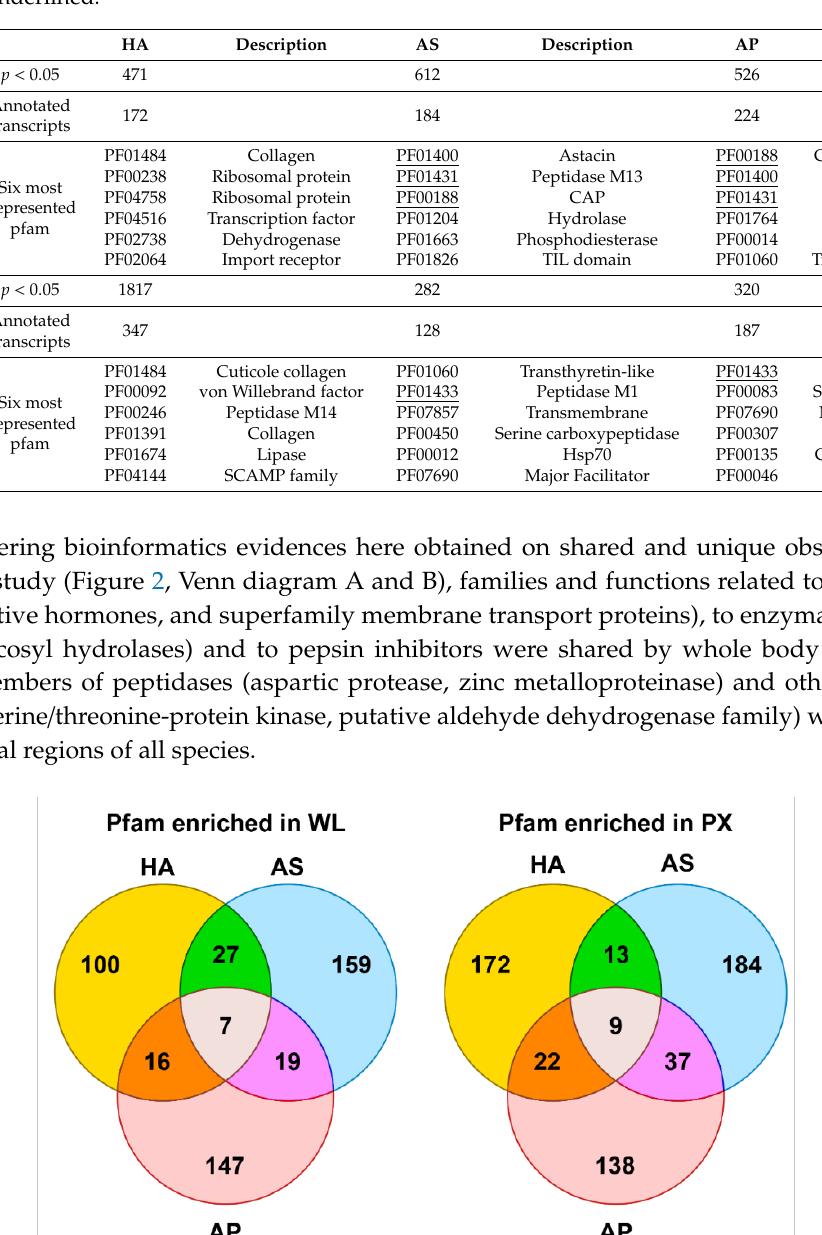
Table 4. Top six pfam (PF) from DEGs analyses. List of the six most represented protein families with codes descriptions resulted from di ff erential expression analyses performed on the whole larva (WL) vs. pharyngeal (PX) transcripts for Hysterothylacium aduncum , Anisakis simplex s.s. and A. pegre ffi i . Shared PF are underlined.